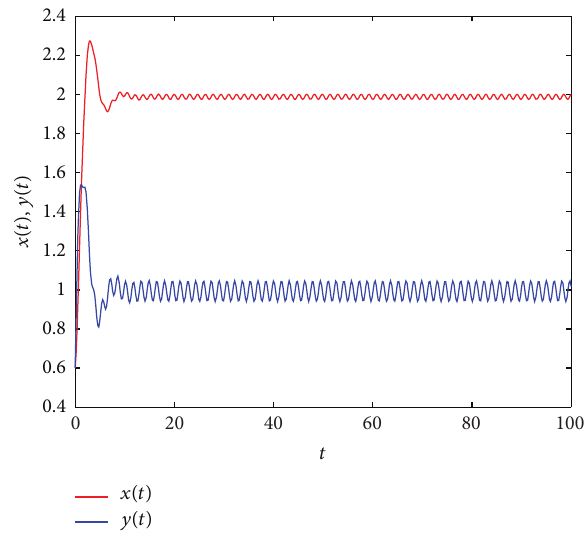
Figure 1: Time response of state variables 𝑥 and 𝑦